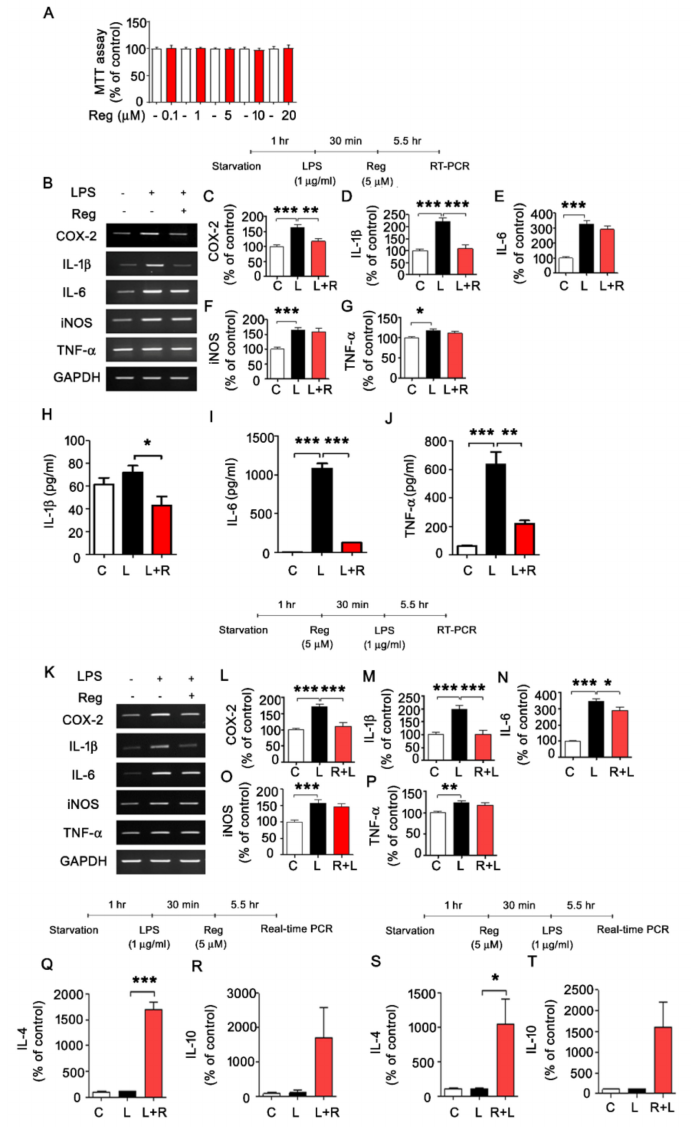
Figure 1. LPS-induced proinflammatory and anti-inflammatory cytokine levels are altered in regorafenib-treated BV2 microglial cells. ( A ) MTT assays were performed after treating BV2 microglial cells with regorafenib (0.1, 1, 5, 10, 20 µ M) or vehicle (1% DMSO) (n = 18 / group). ( B – G ) BV2 microglial cells were pretreated with LPS (1 µ g / mL) or PBS for 30 min, followed by treatment with regorafenib (5 µ M) or vehicle (1% DMSO) for 5.5 h and measurement of proinflammatory cytokine levels (n = 12 / group). ( H – J ) BV2 microglial cells were pretreated with LPS (200 ng / mL) or PBS for 30 min, followed by treatment with regorafenib (5 µ M) or vehicle (1% DMSO) for 23.5 h and measurement of proinflammatory cytokine levels using ELISA (n = 4 / group). ( K – P ) BV2 microglial cells were pretreated with regorafenib (5 µ M) or vehicle (1% DMSO) for 30 min, followed by treatment with LPS (1 µ g / mL) or PBS for 5.5 h and measurement of proinflammatory cytokine levels (n = 12 / group). ( Q – R ) BV2 microglial cells were pretreated with LPS (1 µ g / mL) or PBS for 30 min, followed by treatment with regorafenib (5 µ M) or vehicle (1% DMSO) for 5.5 h. Then, total RNA was isolated, and anti-inflammatory cytokine levels were measured by real-time PCR (IL-4, IL-10; n = 3 / group). ( S – T ) BV2 microglial cells were pretreated with regorafenib (5 µ M) or vehicle (1% DMSO) for 30 min, followed by treatment with LPS (1 µ g / mL) or PBS for 5.5 h. Then, total RNA was isolated, and anti-inflammatory cytokine levels were measured by real-time PCR (IL-4, IL-10; n = 3 / group). * p < 0.05, ** p < 0.01, *** p <